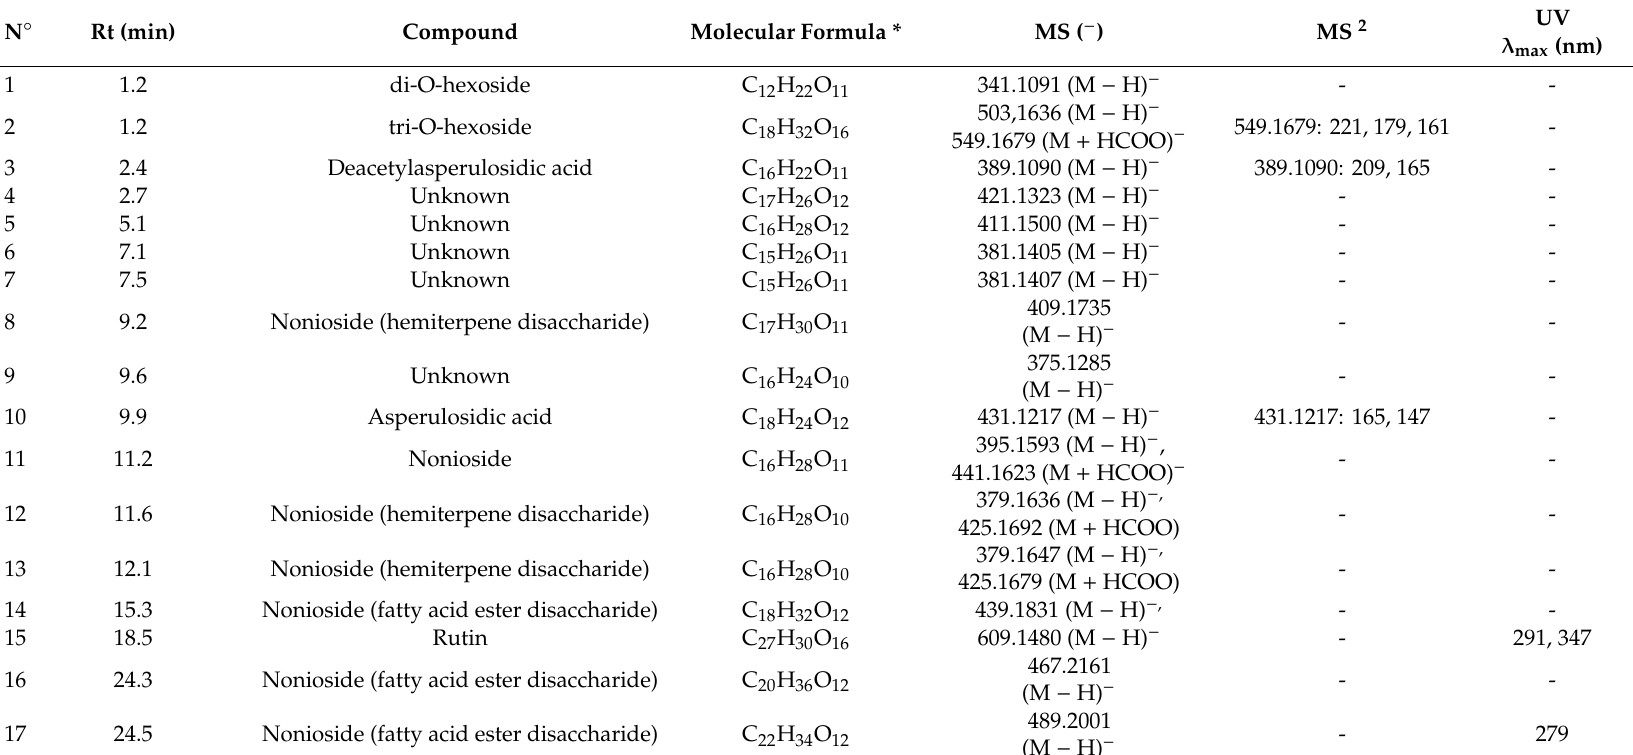
Table 2. Compounds tentatively identified in M. citrifolia aqueous fruit extract